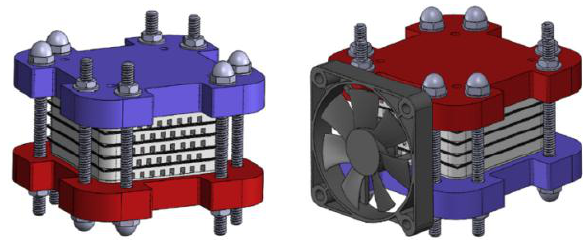
Figure 1. A five cell stack PEM fuel cell [5].